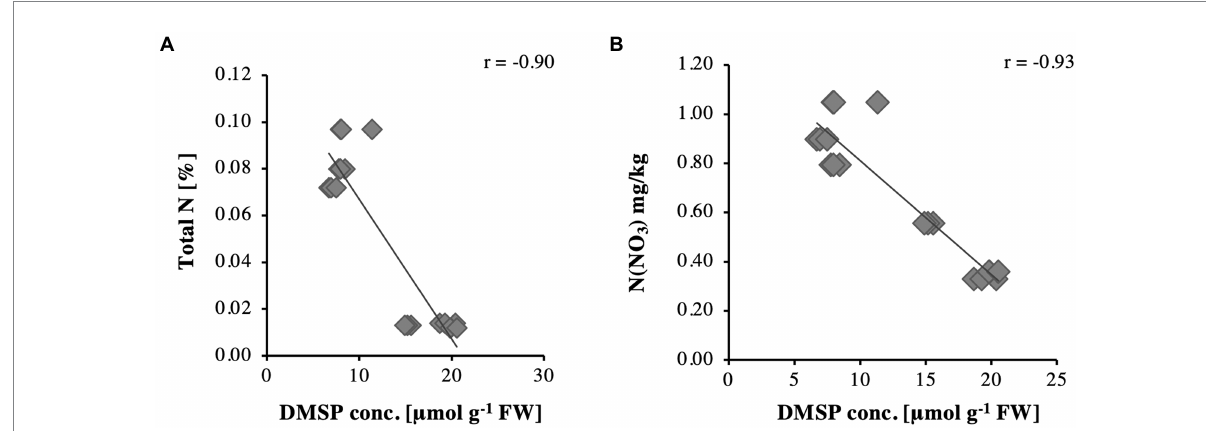
FIGURE 2 Relationships for DMSP concentrations in Sporobolus anglicus leaves in relation to (A) total nitrogen and (B) N(NO 3